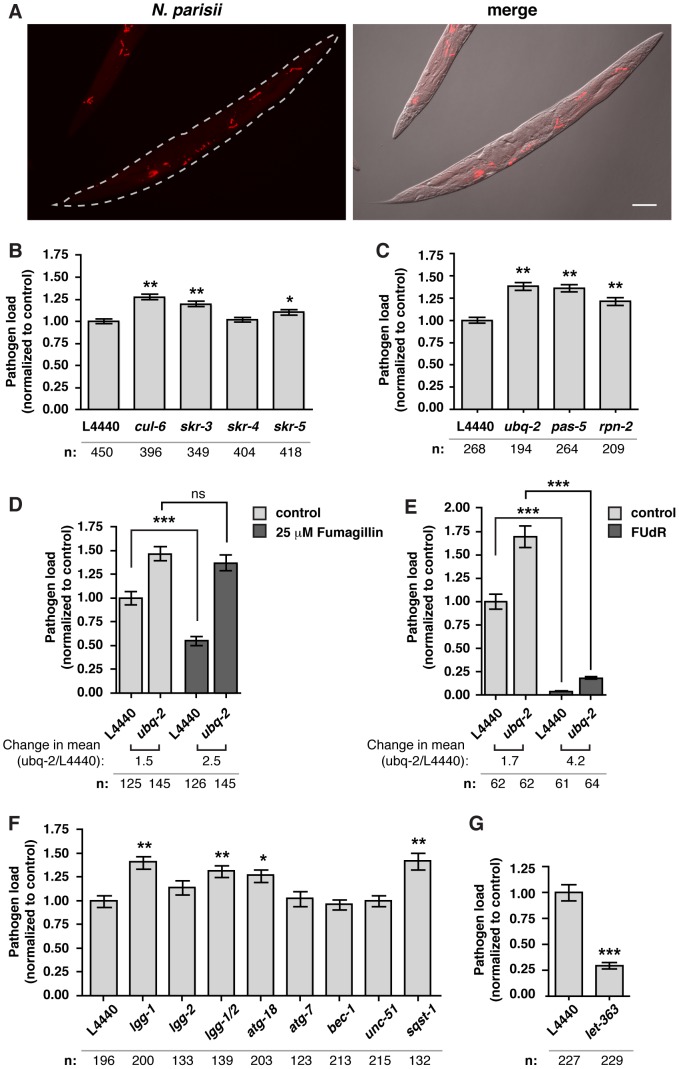
The SCF ligases, UPS and autophagy limit the growth of N. parisii in the C. elegans intestine.A) Fluorescence and bright field images demonstrating FISH staining with a probe against N. parisii rRNA used to quantify pathogen load in the C. elegans intestine following 24 hours of infection with N. parisii. Scale bar  = 100 µm. B–F) Quantification of pathogen load (see Materials and Methods) in nematodes treated with RNAi against SCF ligase components (B), against ubiquitin (ubq-2) and two components of the proteasome (pas-5 and rpn-2) (C), against ubq-2, +/− fumagillin (D), against ubq-2, +/− FUdR (E), against autophagy components (F), and the C. elegans TOR ortholog let-363 (G). Pathogen area occupying each RNAi-treated animal was normalized to mean L4440 control values. The number of animals analyzed for each condition (n) is indicated. Mean +/− SEM is shown for all analyzed animals (data for B, C, F are from three independent experiments, data for D, G are from two independent experiments and data for E are from one experiment). Each independent experiment was comprised of two separate populations of animals. Statistical significance was assessed using a one-way ANOVA with Dunnett's Multiple Comparisons Test for B, C, and F, with Bonferroni Multiple Comparison Test for D and E, and with student's t-test for G (***p<0.001, **p<0.01, *p<0.05).